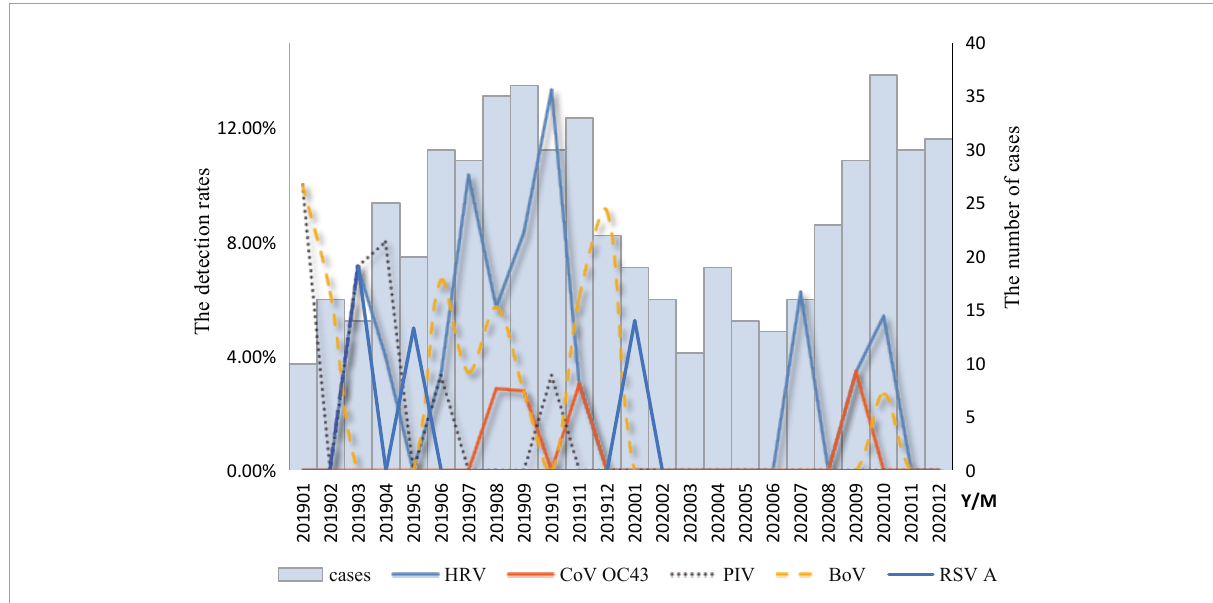
FIGURE2 Temporal distribution of respiratory viruses among diarrhea patients in enteric disease clinics in Beijing from 2019 to